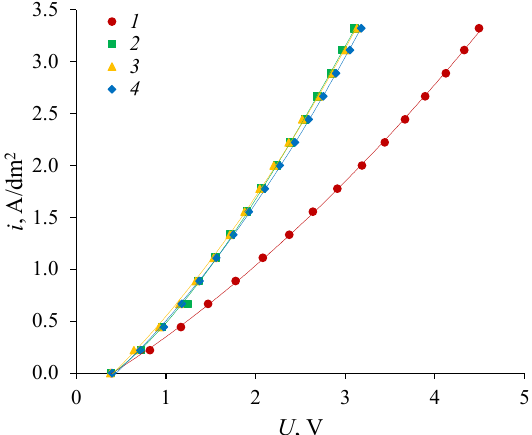
Figure 12. Current-voltage characteristics of the aMB-2m bipolar membrane at different speeds of circulation of solutions: For initial membrane: 1 —2.5 cm/s, for membrane after use in electrodialysis processes: 2 —0.5 cm/s, 3 —1.5 cm/s, 4 —2.5 cm/s. Each curve was calculated by averaging over the overvoltage of three-time measurements of current-voltage characteristics.